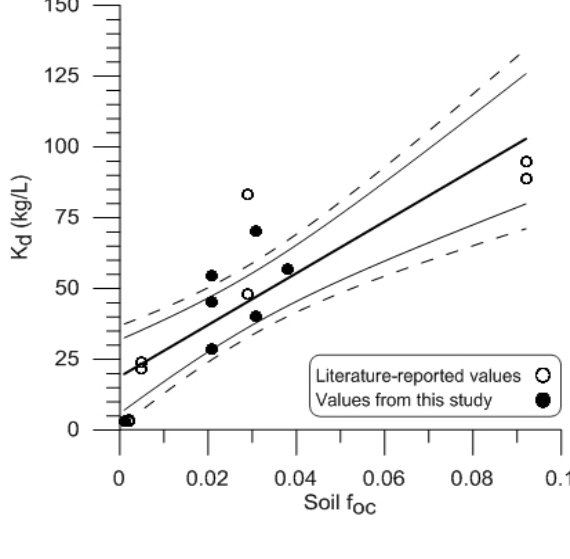
values for associated fraction of organic carbon of soil for isotherms Figure 4. Plots of the K d with less than 20% variability in this study and literature reported values [13,26,27,45] for estrogenic hormones (estrone, 17 β -estradiol, and 17 α -ethynylestradiol). A linear regression fit is included along with the 95% (solid lines) and 99% (dashed lines) confidence